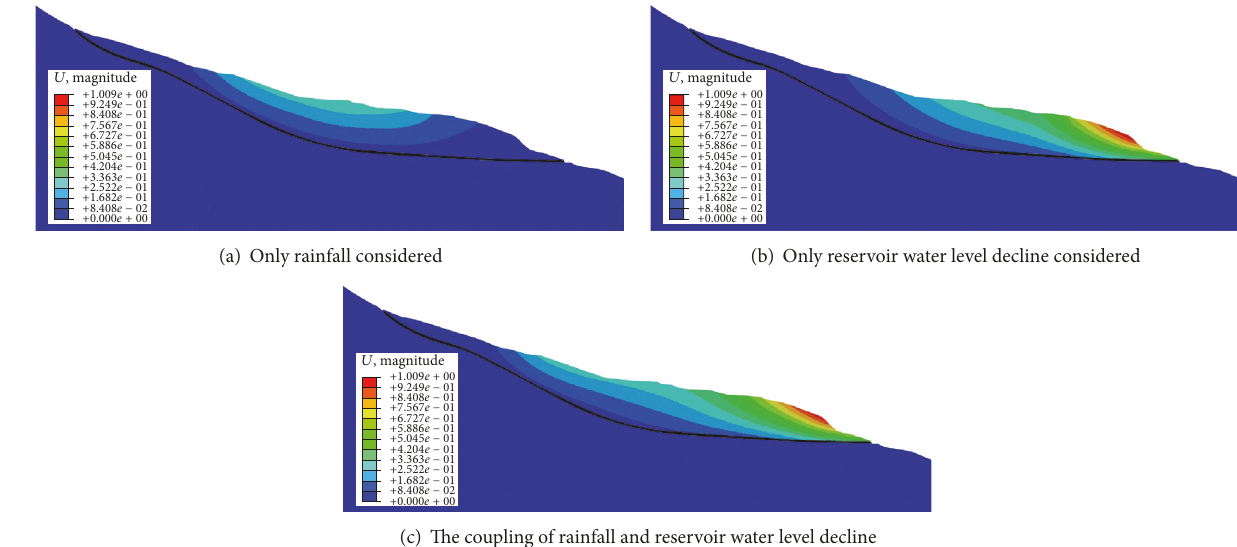
Figure 11: The displacement under different boundary conditions (unit, m).